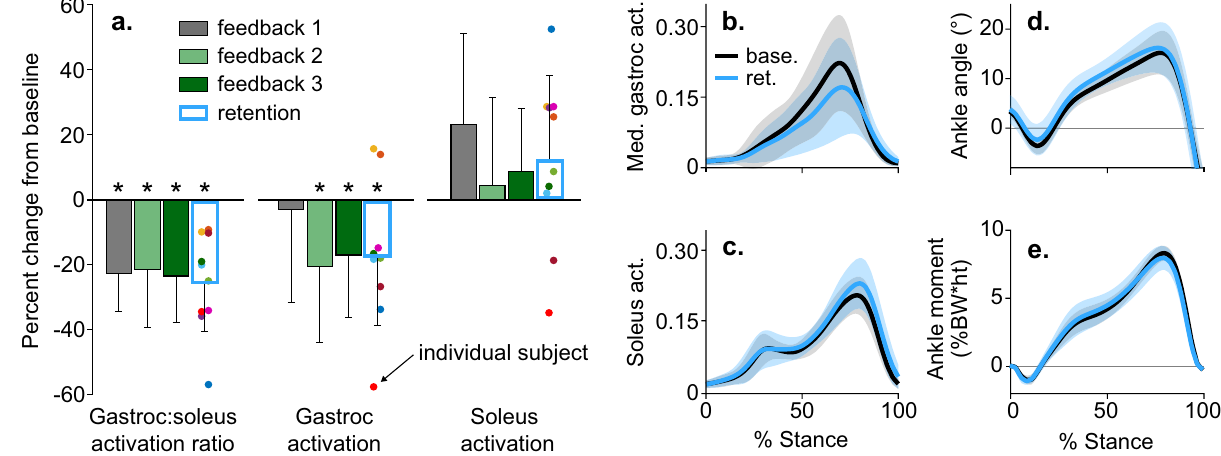
Figure 4. Changes in muscle activity and ankle mechanics following coordination retraining. ( a ) The mean (bar), and standard deviation (error bar) of changes in muscle activation measured with electromyography (n = 10). Participants reduced their gastrocnemius-to-soleus activation ratio and average gastrocnemius (gastroc) activation during training. They retained these reductions following the retention trial (*p < 0.05, paired t test, p-values reported after controlling for the false detection rate). ( b – e ) The mean (line) and standard deviation (shading) of ankle plantarflexor muscle activity and ankle mechanics for the baseline (base.) and retention (ret.) trials. Despite the 25 ± 15% change in activation ratio from the baseline to retention trial, the stance-phase-averaged ankle moment only changed by 3 ± 14%, which trended towards being equivalent to